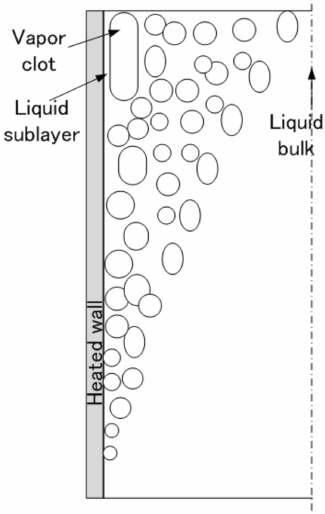
Figure 1. Conceptual view of liquid sublayer dryout